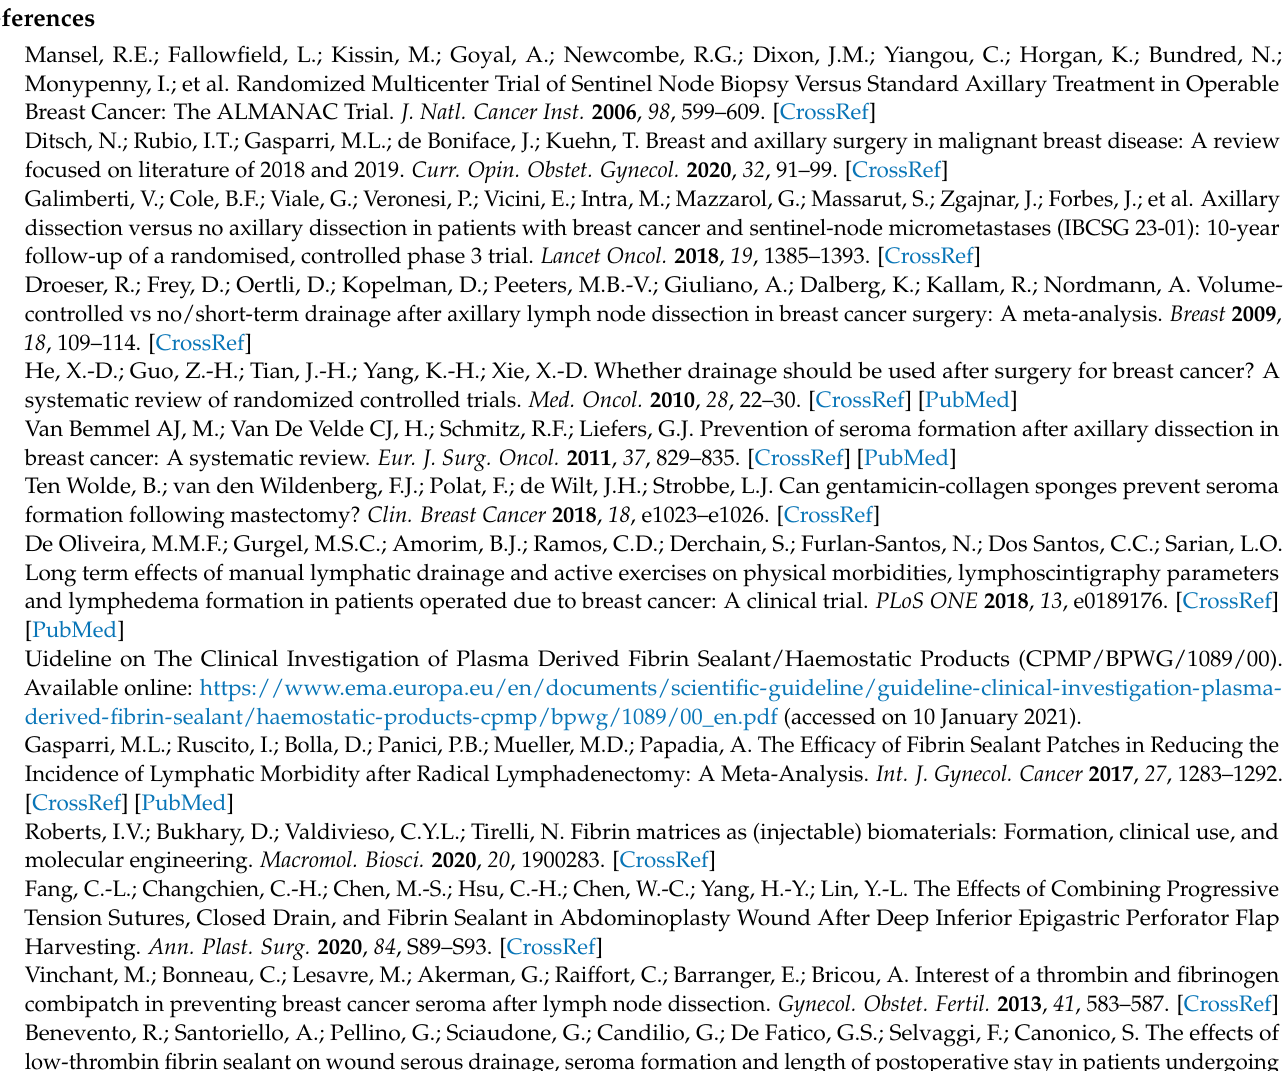
Figure A1. Funnel Plot: Axillary Lymphocele.